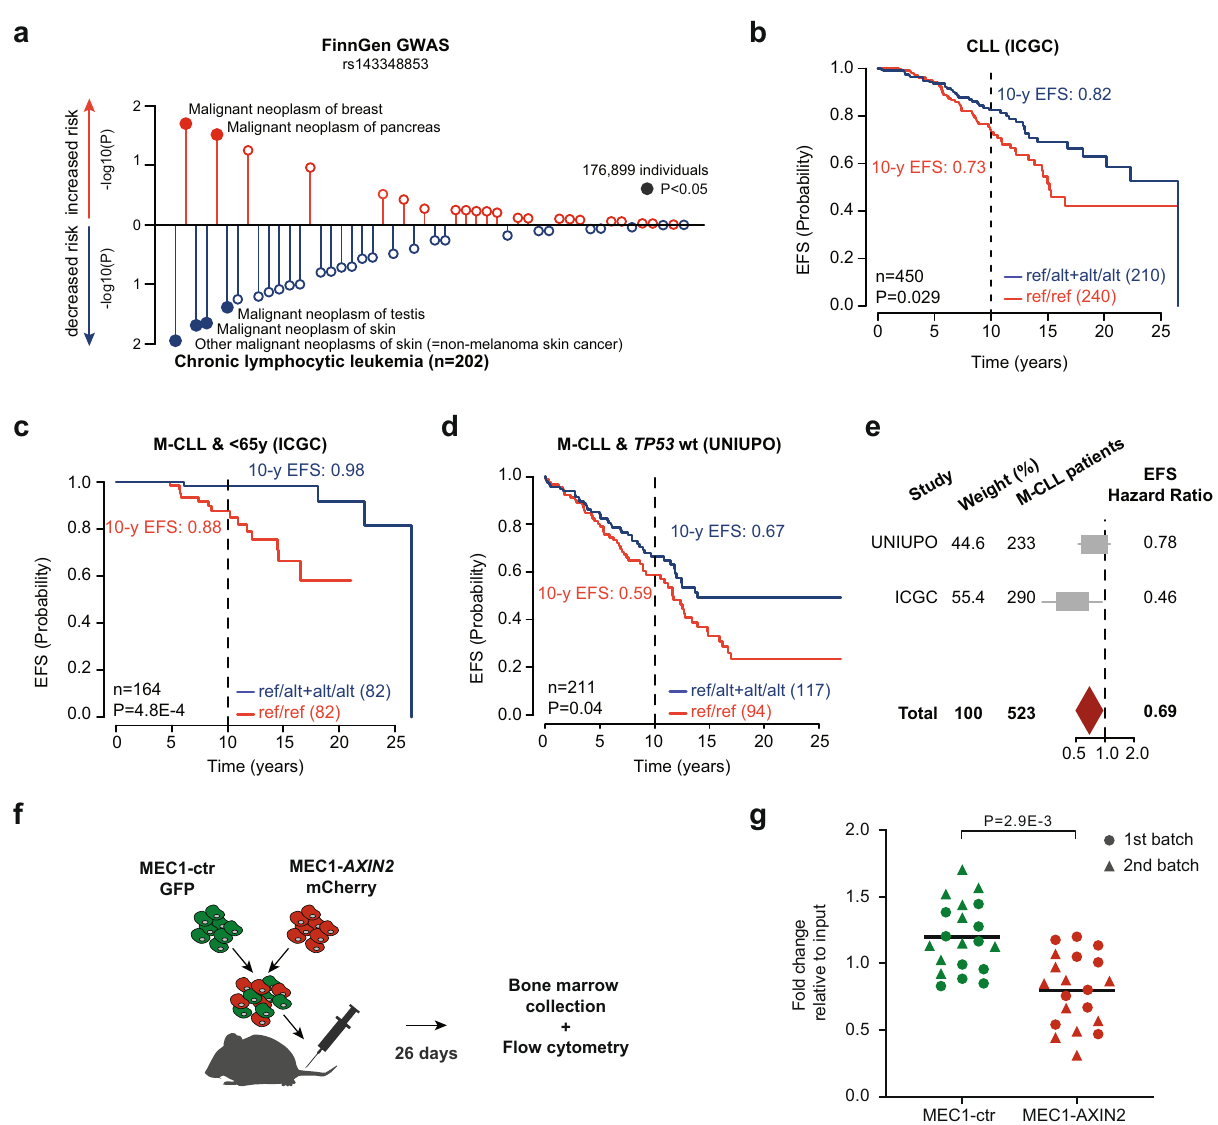
Fig. 3 Association between rs143348853 and CLL predisposition and progression. a Association between rs143348853 and cancer risk based on information from the Finnish cancer registry (FinnGen GWAS study). b Association between rs143348853 deletion carrier status (ref/ref vs. ref/alt + alt/ alt) and event-free survival (EFS) probability in CLL. Data was obtained from the ICGC CLLE-ES project 27,35 . P -values are based on log-rank tests for the two groups and the probability of 10-year EFS is indicated. c Same as b but considering the <65-year-old M-CLL patients only. d Same as b but for the UNIUPO CLL cohort and considering the low-risk (wild-type TP53 ) M-CLL patients only. e Meta-analysis of the rs143348853-EFS-hazard ratios for M-CLL patients obtained from a Cox proportional hazards regression model. f Experimental design for the in vivo competition assay between MEC1-ctr and MEC1- AXIN2 cells. g Fold change of the fi nal cell percentage (day 26) relative to the input percentage (day 0) of MEC1-AXIN2 mCherry + or MEC1-ctr GFP + cells from the in vivo competition experiment; the mean across all 20 mice is displayed, p- value calculated with a paired two-sided t -test. Source data are provided as a Source Data fi le. n and P indicate the number of considered patients and p- value,